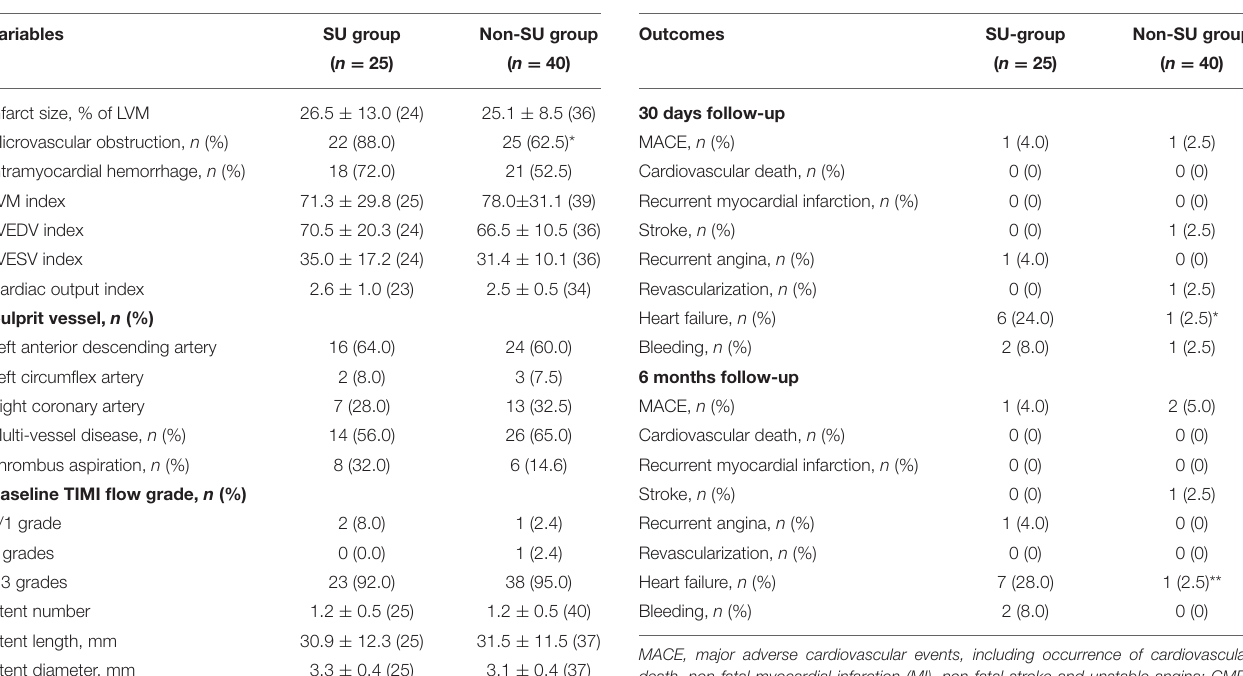
TABLE 3 | Association of sulfonylurea use with CMR imaging results. TABLE 4 | Clinical outcomes in CMR population during